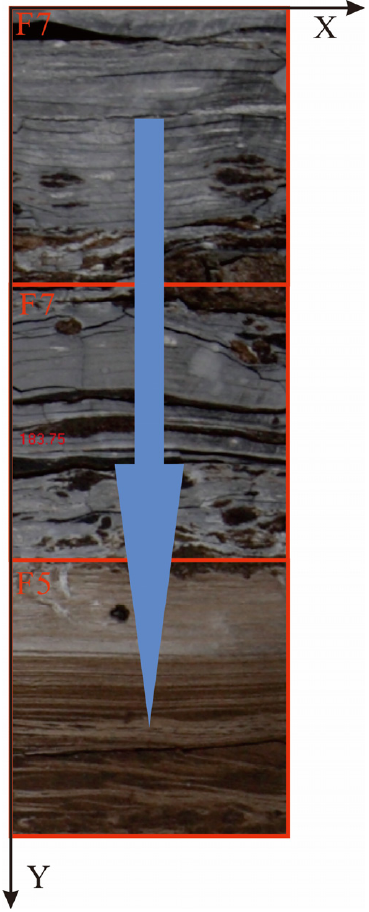
Figure 8. Moving window